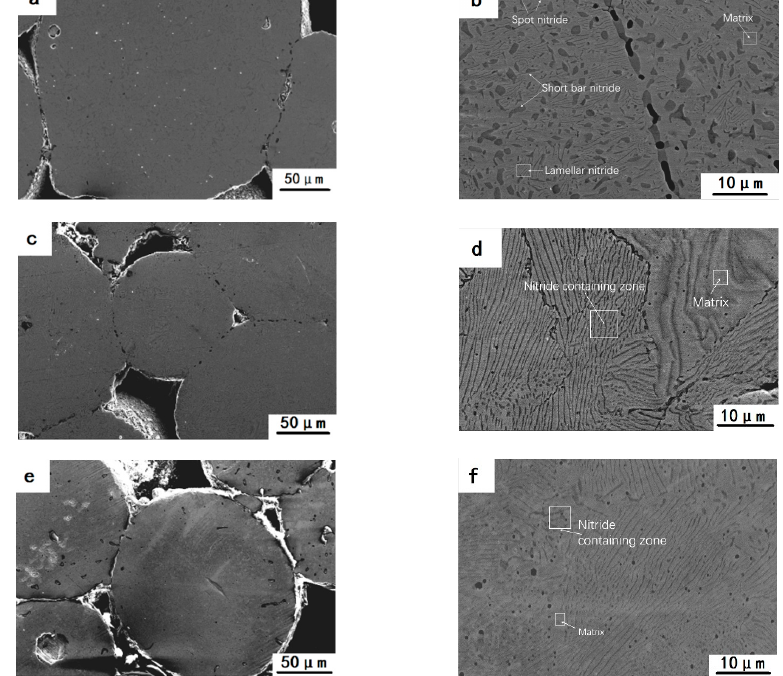
Figure 3. SEM micrographs of as-fabricated samples: ( a , b ) N1200; ( c , d ) N1250; ( e , f ) N1300.